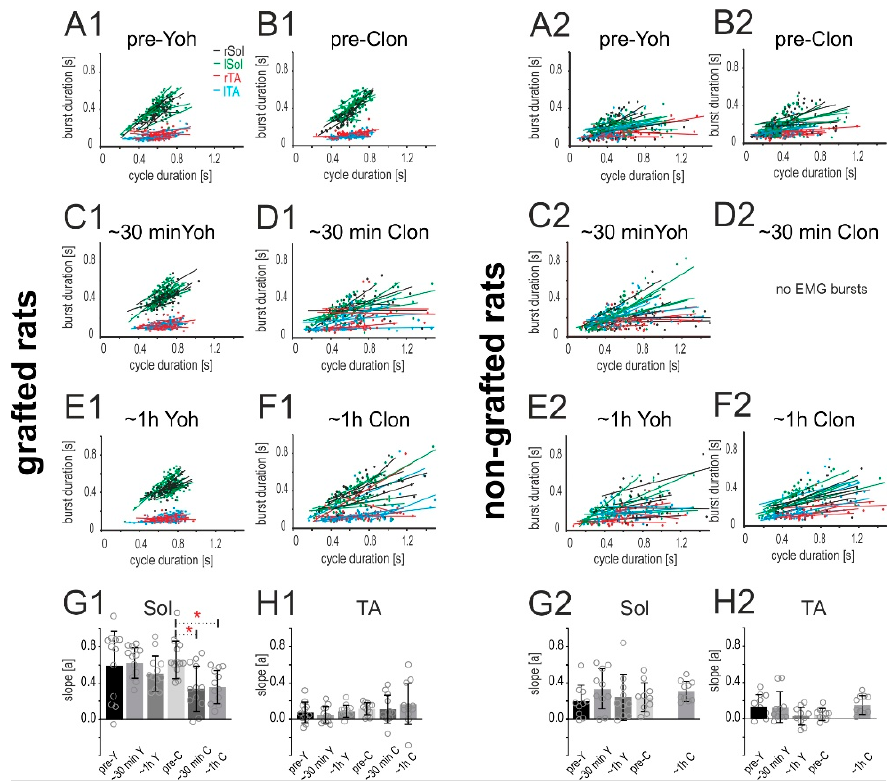
Figure 8. Relationships between burst duration vs. step cycle duration established for the Sol and TA EMG burst activity in both hindlimbs of spinal grafted rats ( n = 6) after yohimbine ( A1, C1, E1 ) and clonidine ( B1, D1, F1 ) application as well as in spinal non-grafted rats ( n = 5) after yohimbine ( A2, C2, E2 ) and clonidine ( B2, D2, F2 ) application. Each regression line established for the burst EMG activity of a given rat muscle is illustrated by a given color (green/black—left/right Sol; blue/red—left/right TA). The bars in G1 , H1 , G2 , H2 represent the slopes (means ± SD) of regression lines of the relationships between the burst duration vs. step cycle durations for the Sol and TA muscles respectively established for the two groups of rats (with and without a graft) in various experimental conditions, while gray circles present the data from individual rats. Note the locomotor deteriorations after clonidine application are associated with the significant decrease of regression line slopes in the case of Sol (G1) but not TA EMG (H1). RM ANOVA with Tukey’s multiple comparisons * p < 0.05. Abbreviations: Sol: soleus muscle; TA: Tibialis Anterior muscle; l: left; r: right; Clon, C: clonidine; Yoh, Y: yohimbine; ~30 min: < 30 min after drug application; ~1 h: one hour after drug application.